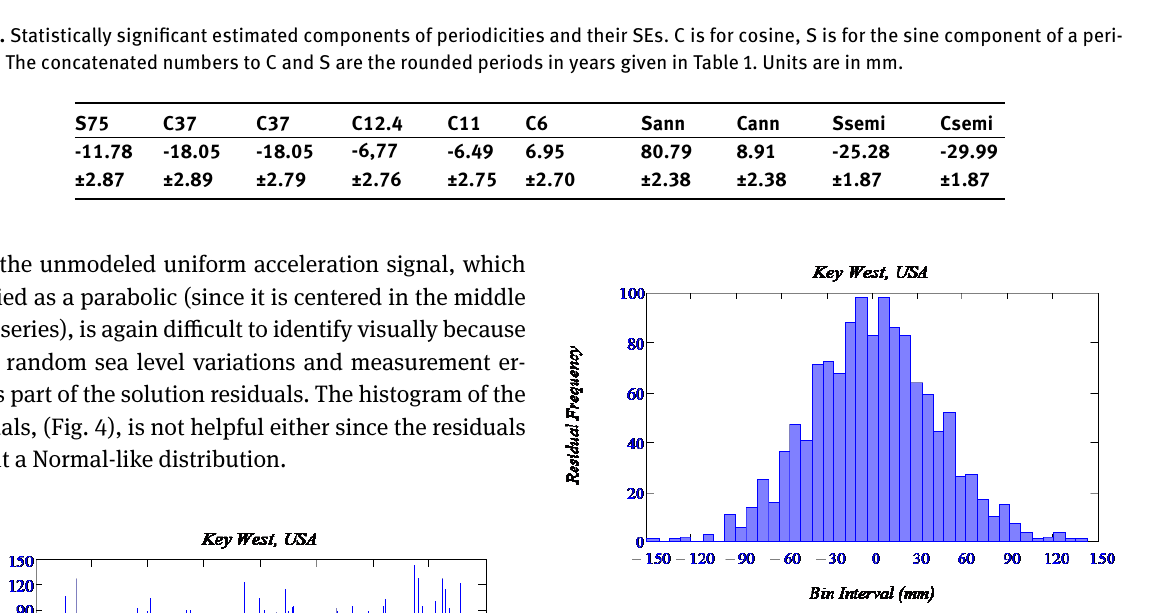
Fig. 4. The histogram of the residuals still exhibits a Normal-like distribution despite the unmodeled